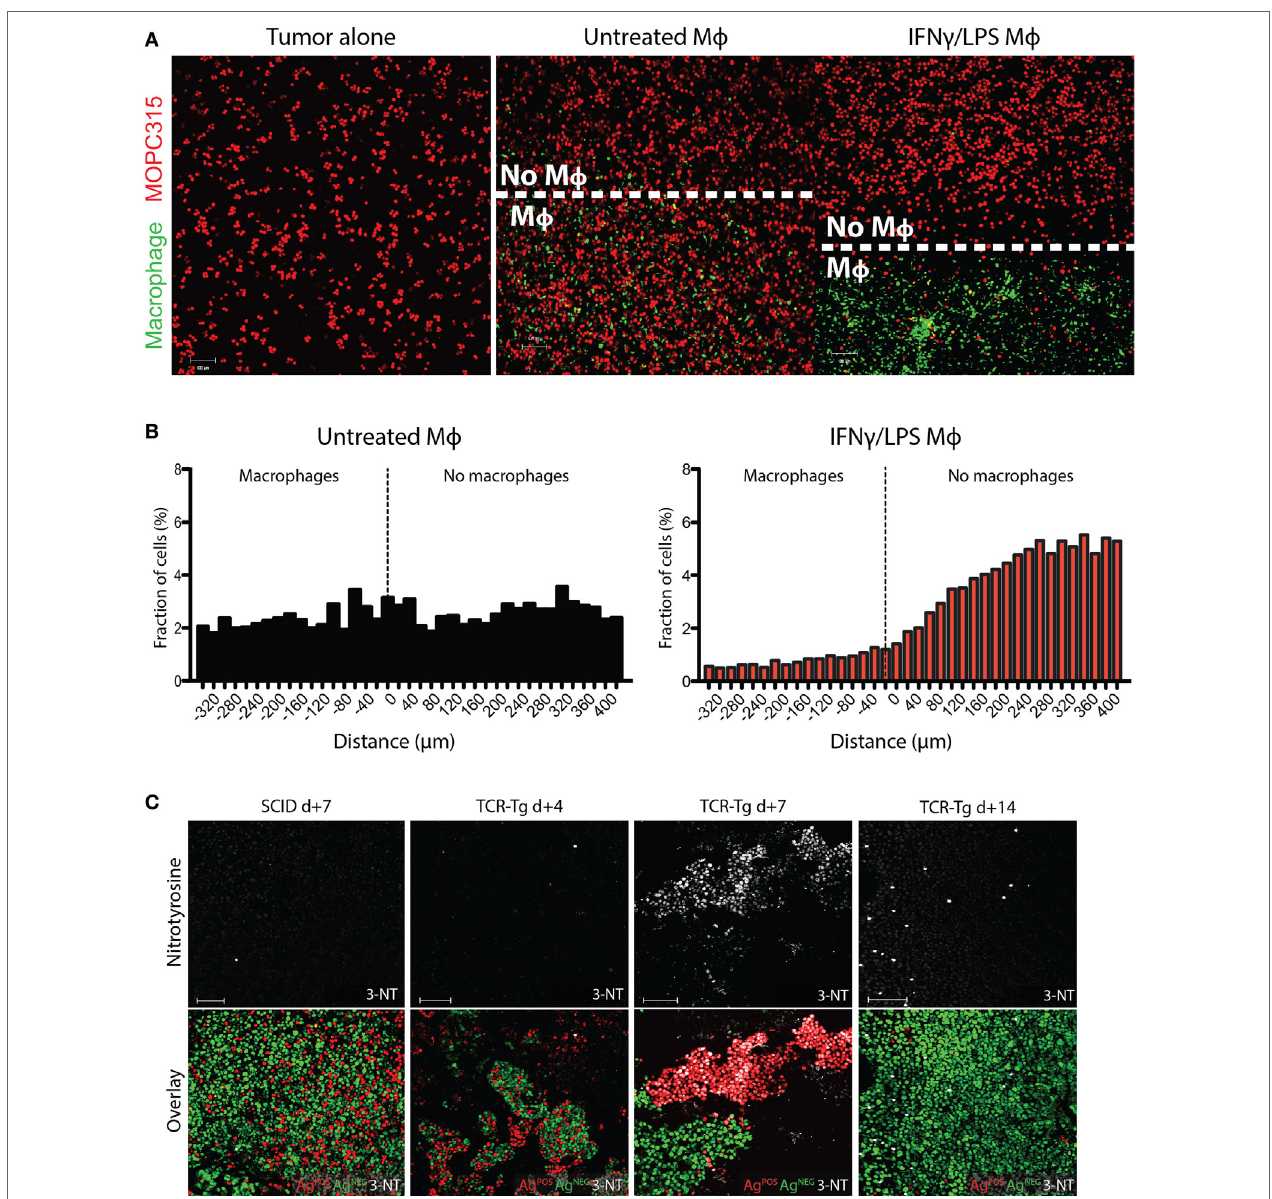
FigUre 5 | Spatial restrictions of inducible nitric oxide synthase (iNOS)-mediated killing of tumor cells. (a) Representative images of in vitro Matrigel co-culture assays of peritoneal macrophages (green) and MOPC315 cells (red). Cell-culture insert confining the adherent macrophages to a defined portion of the well were removed after adhesion, prior to co-culture with tumor cells. Images show the border areas in cultures of tumor cells cultured alone or in the presence of untreated or interferon gamma (IFN- γ )/LPS-activated macrophages for 24 h. (B) Spatial distribution of tumor cells relative to the front of the macrophage layer in the assay described in (a) , expressed as shortest border-border distance ( μ m). Results were obtained by distribution plotting of 2 × 10 4 tumor cells per treatment condition, based on three independent assays. Results are expressed as relative frequencies within the range of − 340 to + 400 μ m from the macrophage border. See also Movies S1 and S2 in Supplementary Material. (c) Representative immunofluorescence staining for 3-nitrotyrosine (white) of Matrigels on days + 4, + 7, and + 14 following s.c. challenge with 1:1 mixtures of antigen-secreting (Ag POS ; red) and antigen-negative (Ag NEG ; green) MOPC315 cells in Id-specific T cell receptor- transgenic (TCR-Tg) SCID and SCID mice. Images were taken at 10 × magnification. 100 µm scale bars are shown in white.